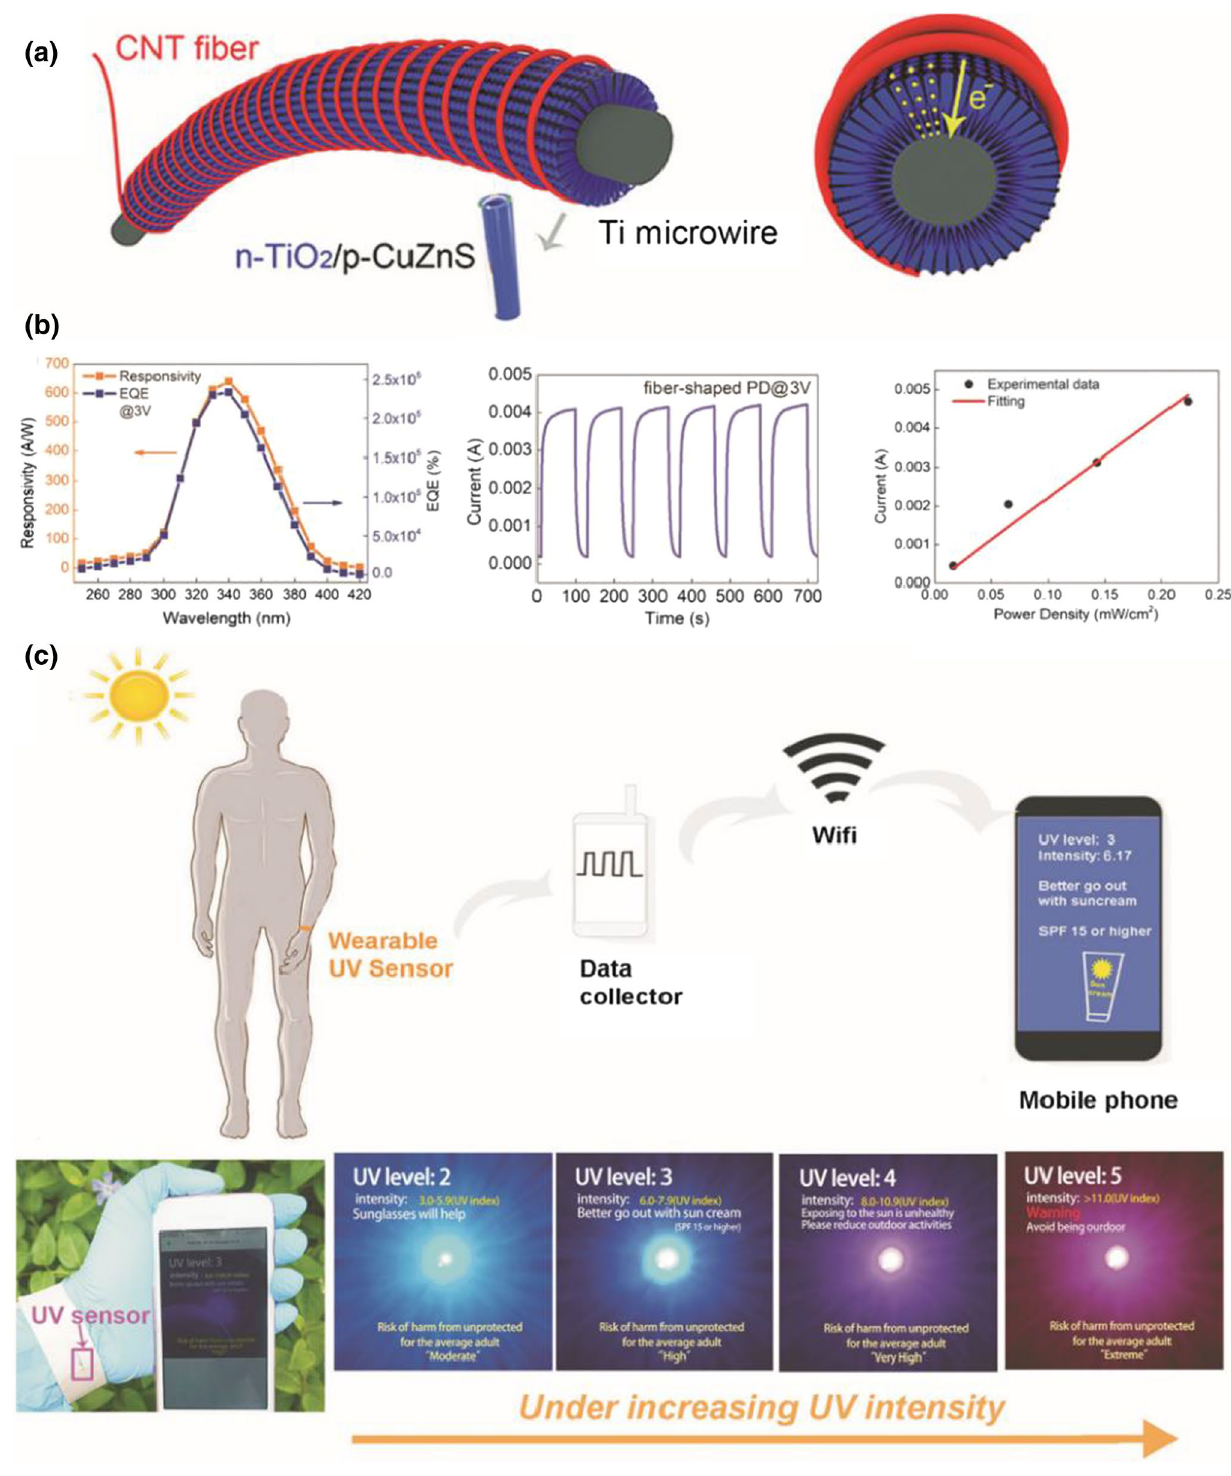
Fig. 10 a Device structure of the fiber-shaped p -CuZnS/ n -TiO nanotube-based photodetector. b Responsivity and EQE of the fiber-shaped 2 photodetector under 350 nm at 3 V, together with the on–off switching tests, and experimental and calculated photocurrent as a function of power density. c Schematics of the wearable photodetector as a real-time UV monitor and images of the wearable real-time UV sensor in real life. Reproduced from [107] with permission of John Wiley and